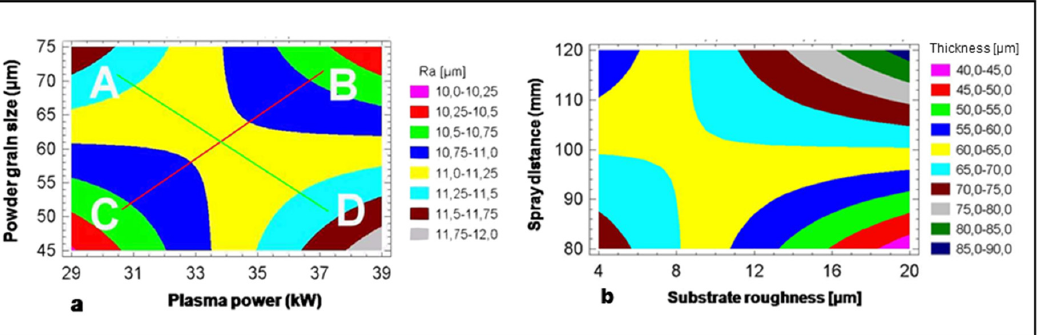
Figure 5. Response surface contours of average surface roughness R a ( a ) and thickness ( b ) of Cr 2 O 3 coatings plasma-sprayed onto steel St37 surfaces using a 2 5 − 1 fractional factorial design. Panel ( a ): Average surface roughness R a as a function of plasma power and powder grain size. Panel ( b ): Coating thickness as a function of substrate roughness and spray distance. © With permission by Wiley-VCH, Weinheim, Germany.